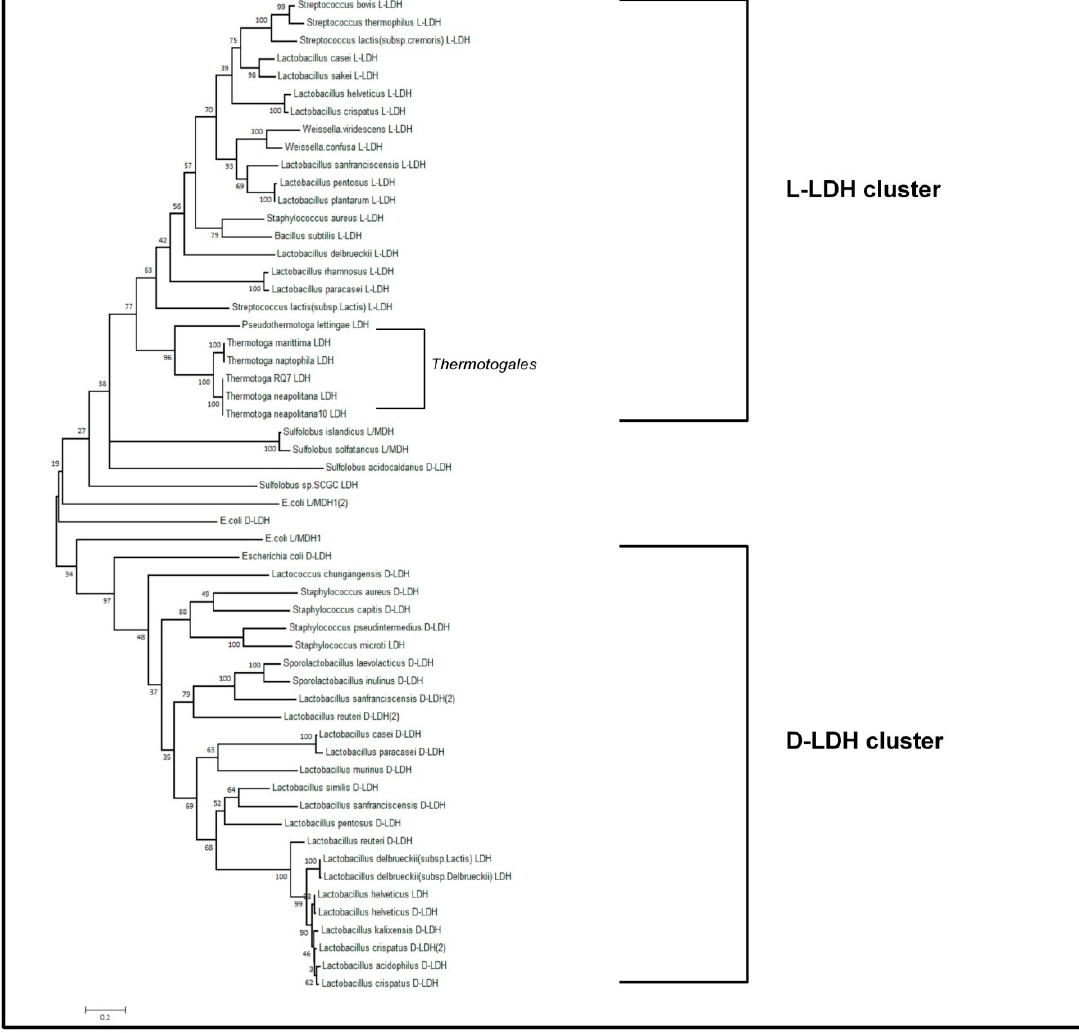
Figure 2. Un-rooted phylogenetic tree of lactate dehydrogenase amino acid sequences constructed 166 using maximum likelihood method. The bootstrapping test (replicate = 100) is indicated on each node, 167 in order to test the phylogeny. 168